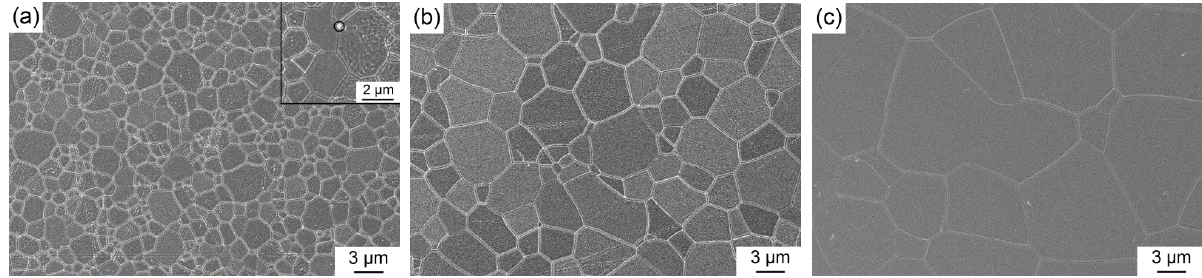
Fig. 9 FESEM micrographs of the thermally-etched surfaces of 8YSZ ceramics pre-sintered at 1280 ℃ for 4 h in air and HIP post-treated at (a) 1350 ℃ , (b) 1450 ℃ , and (c) 1550 ℃ for 3 h under 176 MPa